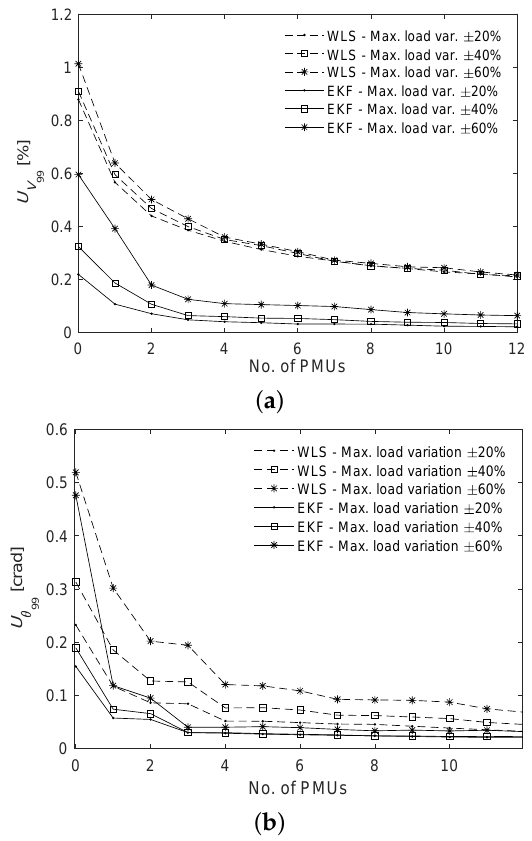
Figure 5. 99-th percentiles of ( a ) the bus RMS voltage relative estimation errors and ( b ) the phase estimation errors obtained with the enhanced EKF and the WLS algorithm, respectively, under different load conditions and considering traditional pseudo-measurements only. The maximum TVE of all PMUs deployed is